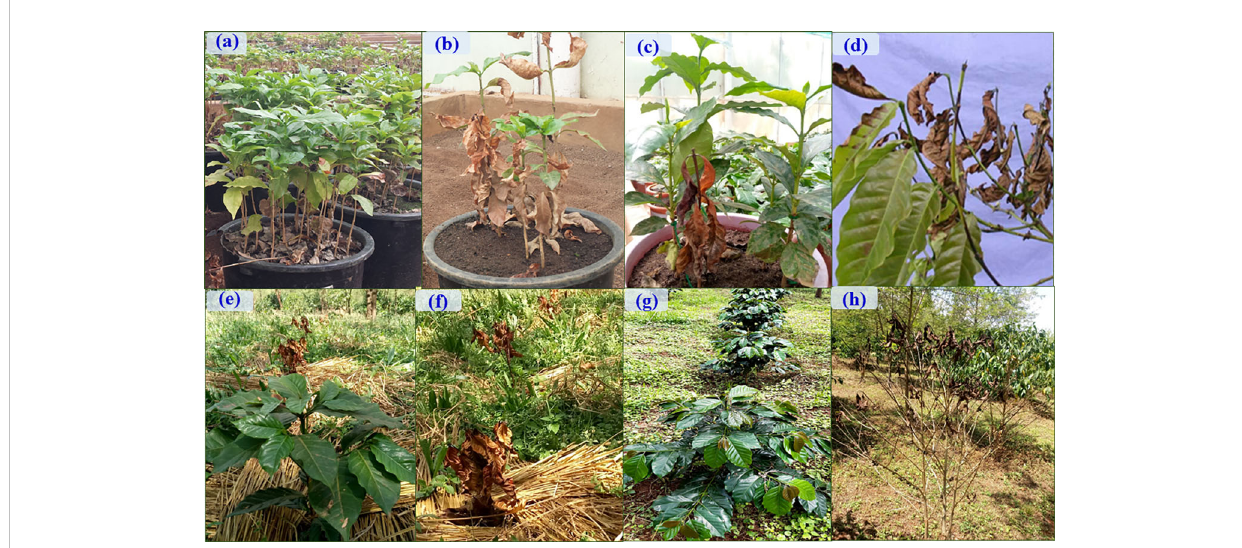
FIGURE 7 Characterization and evaluation of Trichoderma isolates as a biocontrol agent for against F . xylarioides on coffee seedlings under greenhouse and fi eld conditions. Greenhouse experiment: (A) Negative control ( F. xylarioides and biofungicides were not applied), (B) Positive control ( F. xylarioides was applied to Geisha coffee seedlings) and (C) Geisha coffee seedlings treated with biofungicides (WDG and WP). Field experiment: (E) Negative control ( F. xylarioides and biofungicides were not applied), (F) Positive control ( F. xylarioides was applied to Geisha coffee plants) and (G) Geisha coffee seedlings treated with Wettable powder (WP) biofungicide. Typical symptoms: (D) and (H) are characteristic wilting symptoms manifested in Geisha coffee plants. The coffee plants treated with biofungicides and challenged with the pathogen showed healthy growth indicating the protection offered by Trichoderma species as a biocontrol